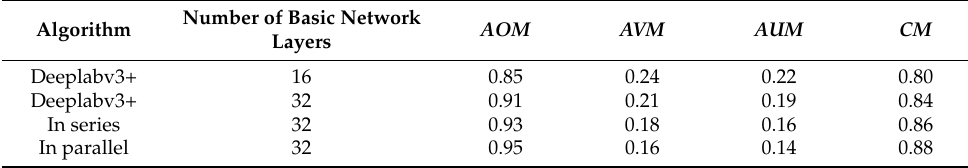
Table 5. Short coastline extraction effect.